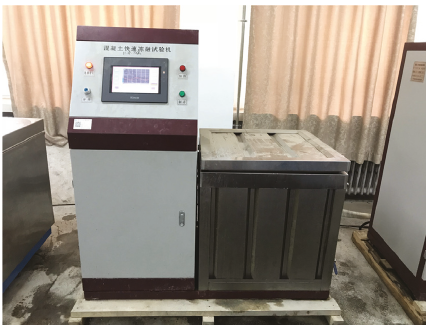
Figure 1: Equipment used to conduct rapid freeze-thaw test.